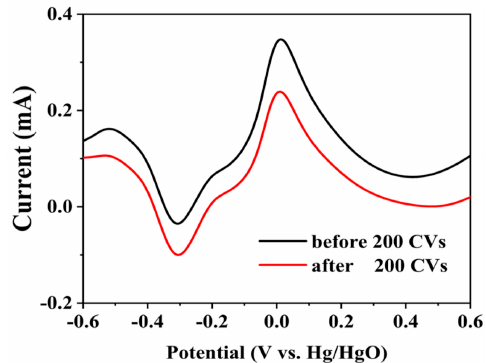
Figure 7. LSVs at Pd/C 3 N 4 -C before and after 200 CVs. Ten mM glucose, and 0.1 M NaOH. 50 mV s − 1 .